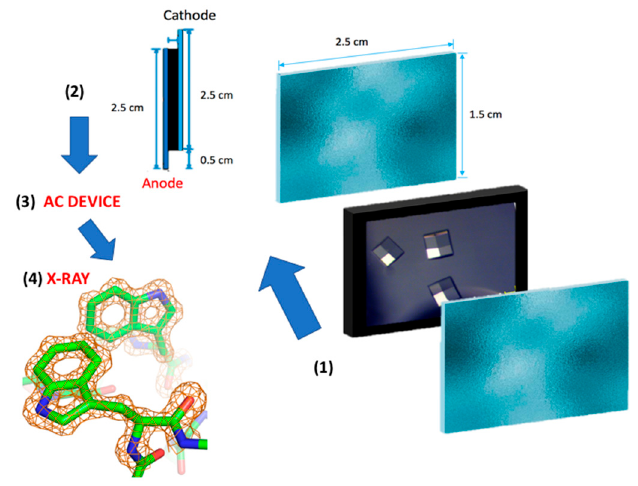
Figure 1. The growth cell ( 1 ) and the setup used along these experiments for the electric field approach ( 2 , 3 ) up to the 3D structure by X-ray crystallography ( 4 ). The electrodes are made of Indium Tin Oxide (ITO) glass. The electron density maps (2Fo-Fc) of the best crystals at a contour level of 1 σ is shown after X-ray crystallographic analysis.